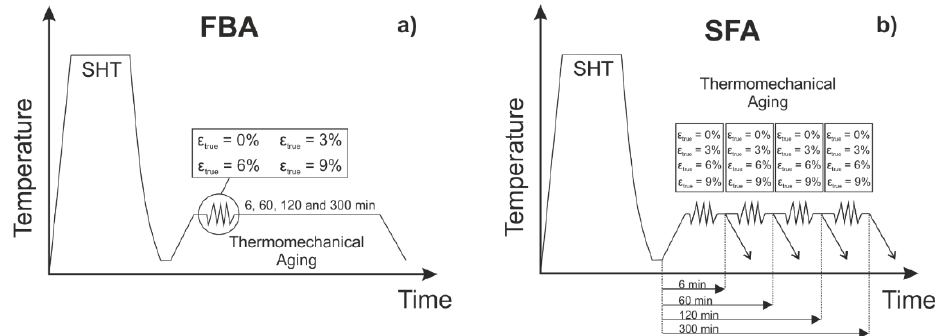
Figure 1. Experimental process routes of ( a ) FBA and ( b ) SFA after solution heat treatment and water quench.